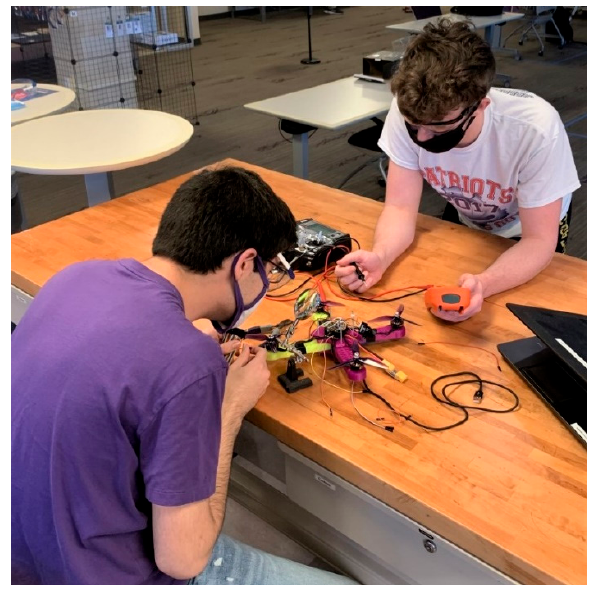
Figure 8. ARC students working for a competition.